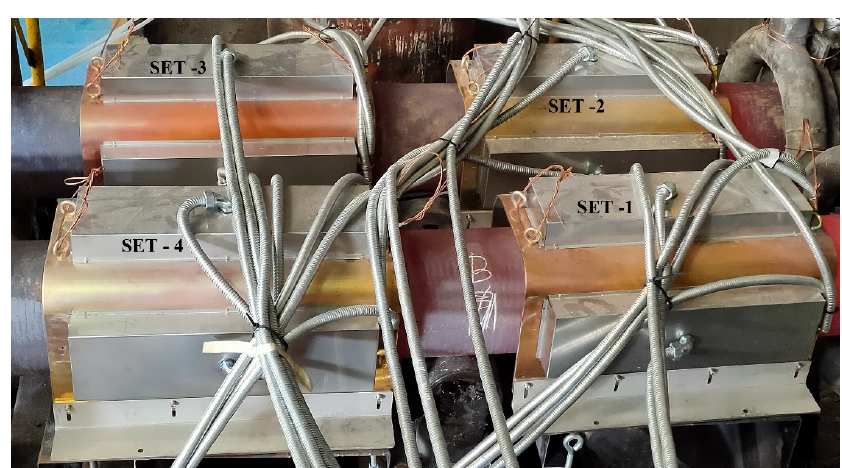
Figure 2. Photographic view of the waste heat recovery system using thermoelectric generators